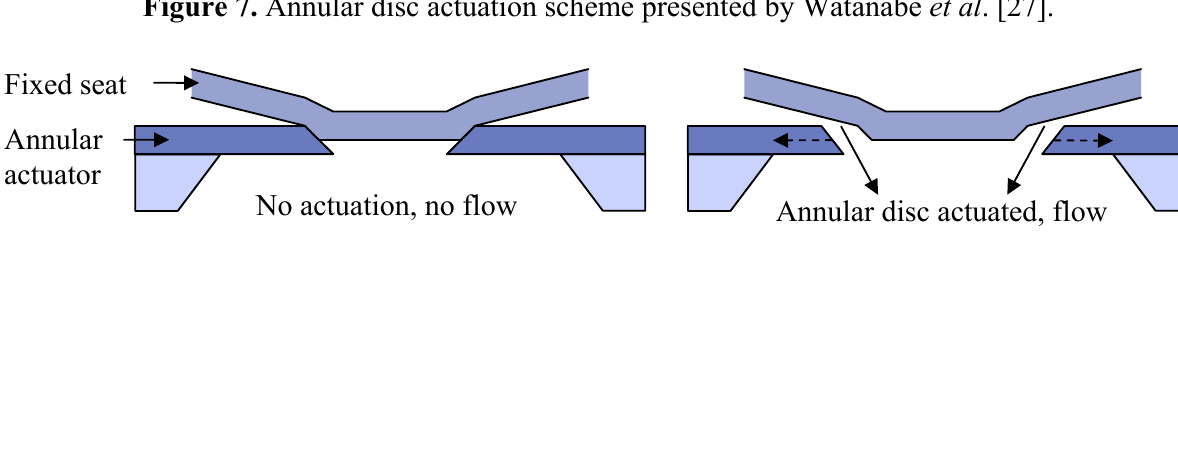
Figure 7. Annular disc actuation scheme presented by Watanabe et al .